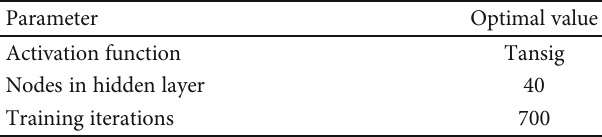
Table 4: Optimal values of training